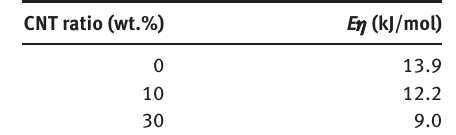
Figure 2 Relationship of viscosity and temperature of the dispersed phase.